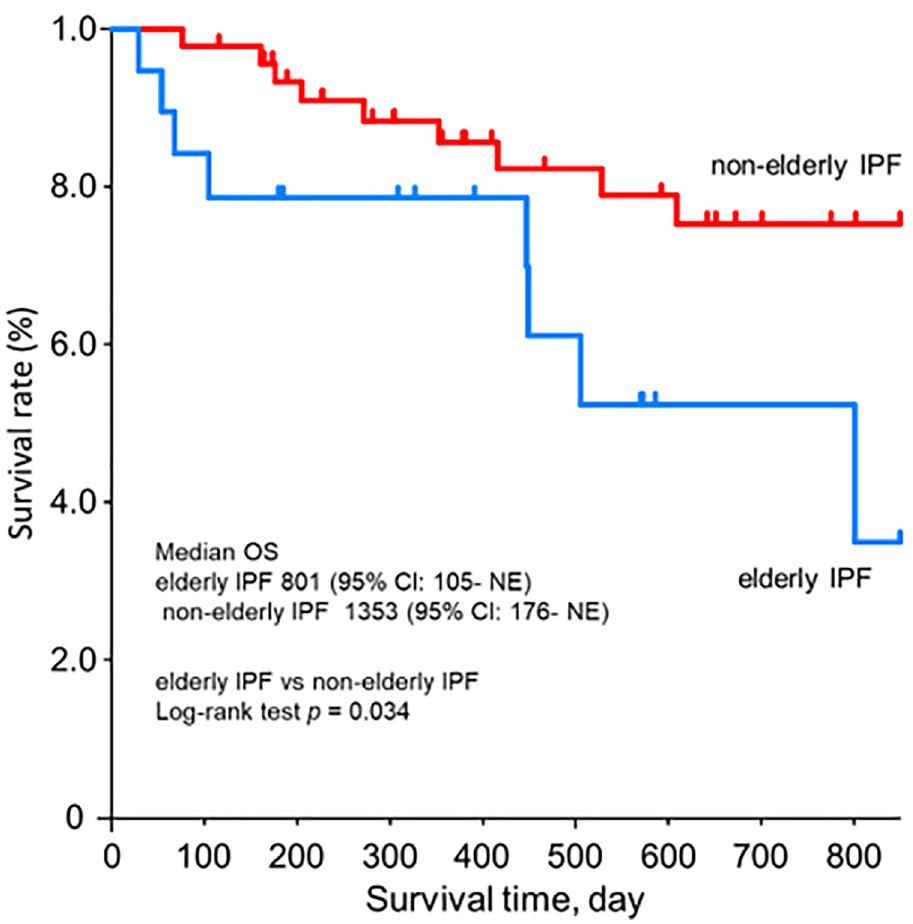
Fig 3. Survival curves of elderly IPF and non-elderly IPF after nintedanib initiation. The Kaplan-Meier curve of the overall survival of the IPF patients (elderly IPF, and non-elderly IPF). (Blue: elderly IPF, red: non-elderly IPF). Abbreviations: CIs: confidence intervals, IPF: idiopathic pulmonary fibrosis, NE: not evaluable, OS: overall survival.